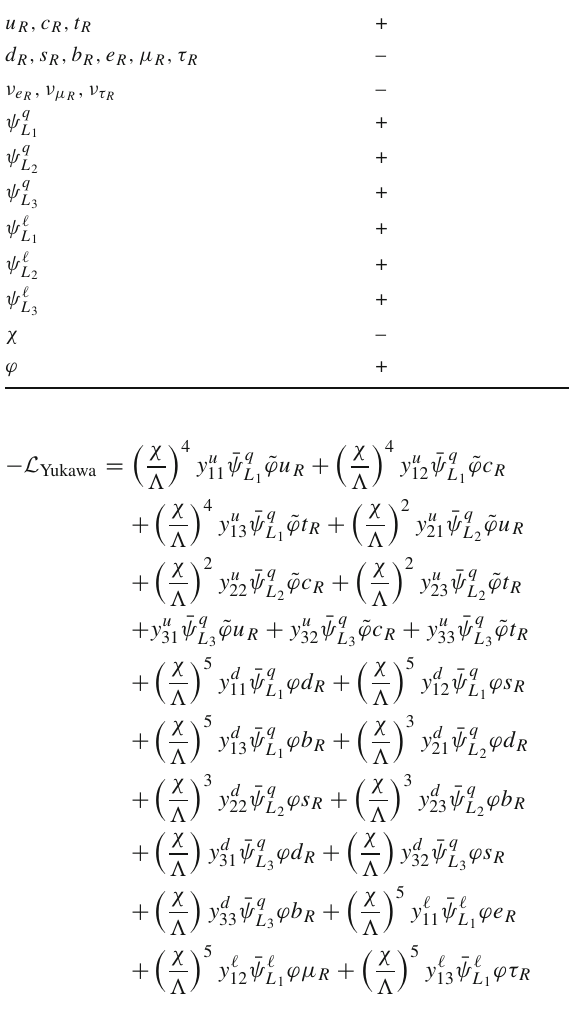
ω is the fifth root of unity